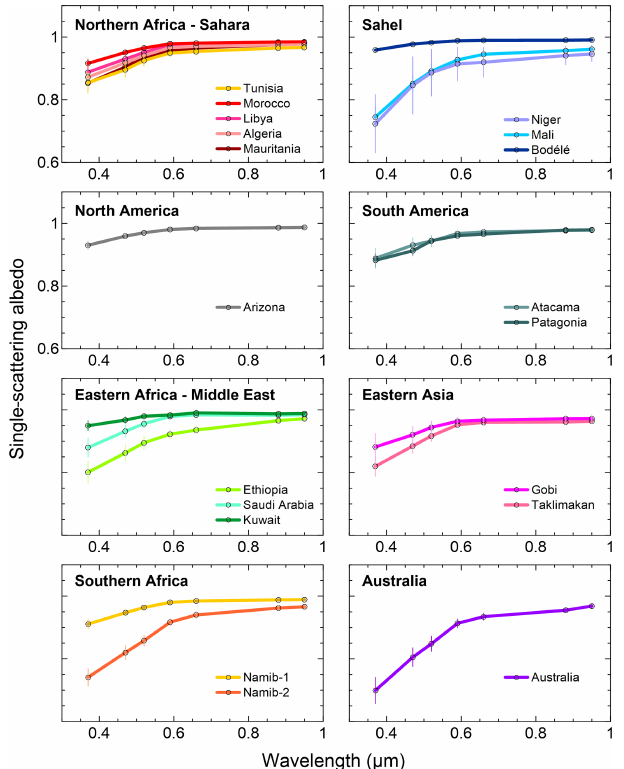
Figure 7. Single-scattering albedo (SSA) at seven wavelengths be- tween 370 and 950nm obtained for the 19 aerosol samples analyzed in this study. Data correspond for each sample (with the exception of Tunisia and Namib-2; see Sect. 3.1) to the fit of the 10min values of β sca versus β abs , and the uncertainty is between 1% and 12% at 370nm and between 1% and 3% at